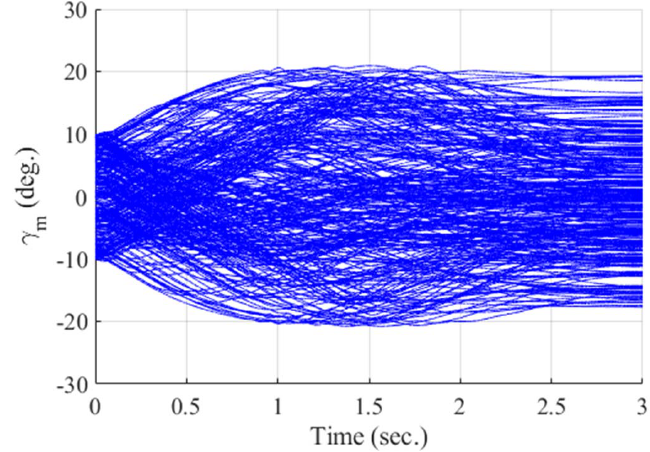
Figure 17. Flight-path angle of the missile (Monte Carlo